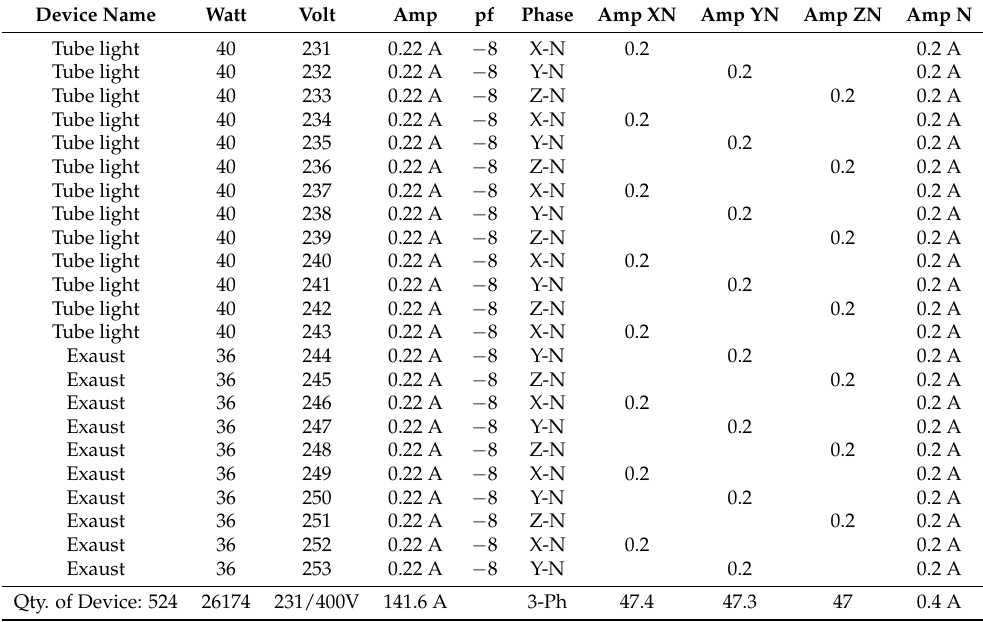
Table 13. Academic Block proposed load data (1).